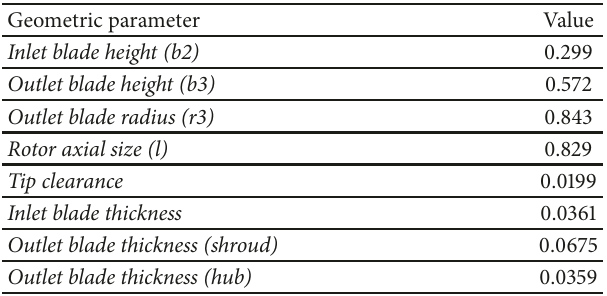
Table 2: Rotor geometrical dimensionless parameters.